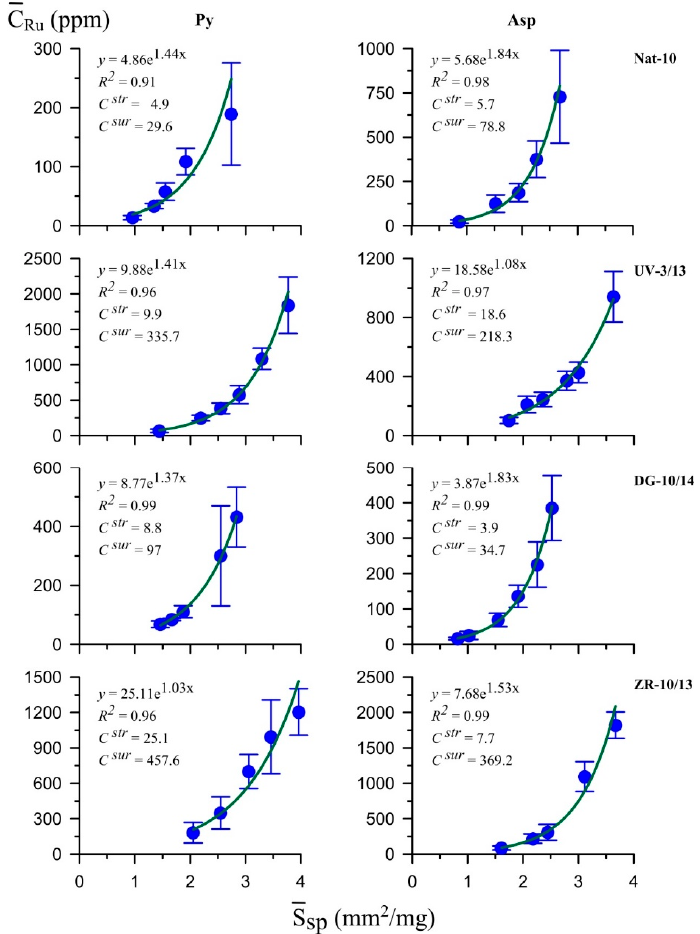
Figure 8. Dependence of the average concentration of evenly distributed Ru in pyrite and arsenopyrite on the specific surface area of an average crystal in size fraction. See Figure 5 for explanations.